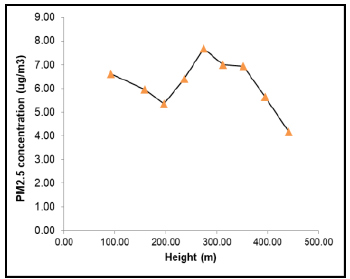
Figure 14. PM 2.5 concentration changes with the increase of